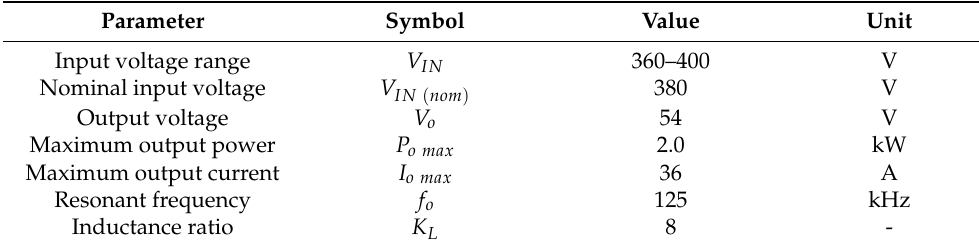
Figure 12. Operating range of LLC converter. Table 3. Design Conditions for LLC Resonant